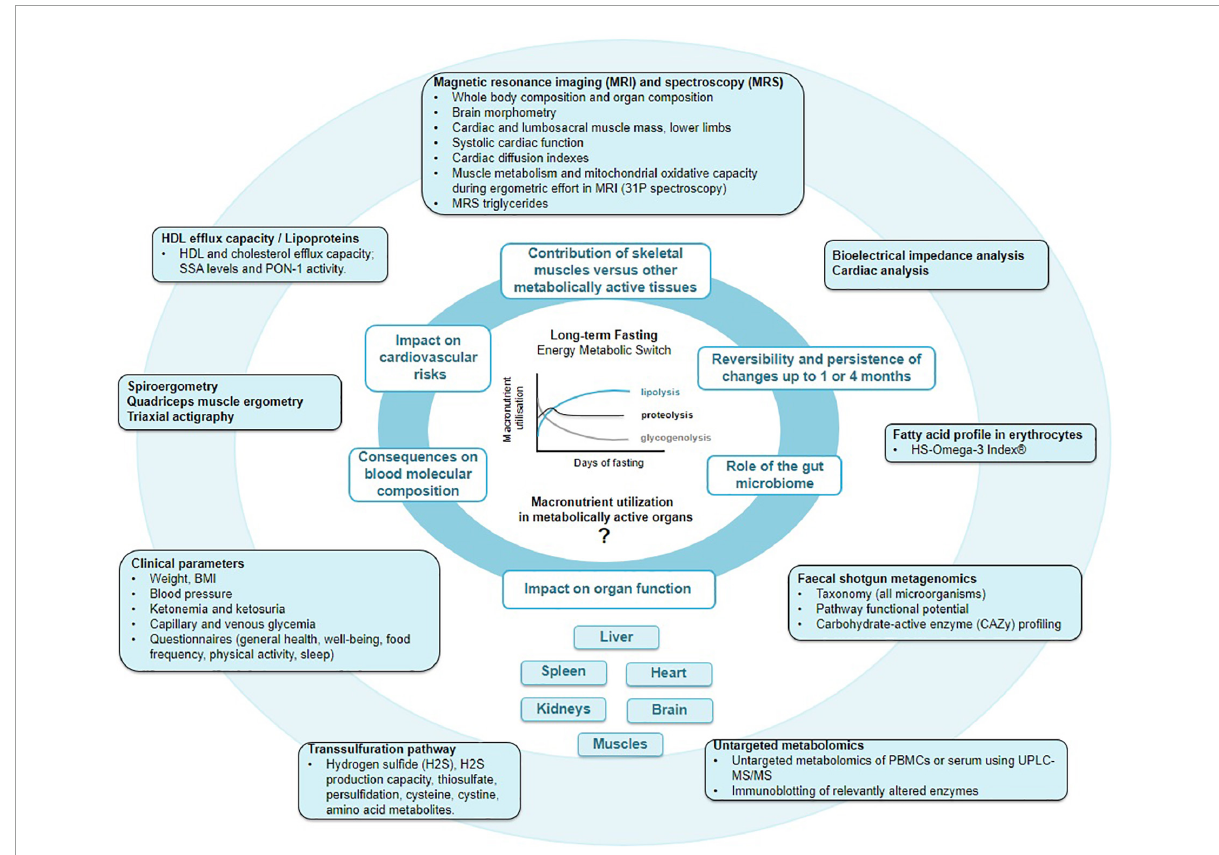
FIGURE1 Main outcomes of the GENESIS study. By pooling knowledge acquired by macroscopic multi-organ fat distribution and composition provided by magnetic resonance imaging (MRI), with erythrocyte fatty acids, lipoprotein, peripheral blood mononuclear cell (PBMC) metabolome, protein persulfidation, and gut microbiome profiles, we aim to gain a deeper comprehension of molecular and physiological changes during fasting and food